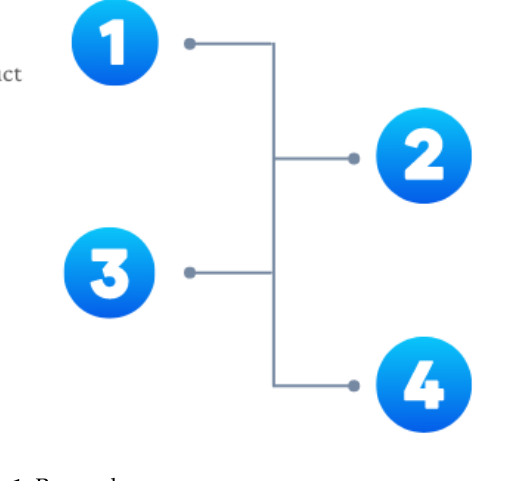
Figure 1. Research process. Table 1. Characteristics of the vehicles used in the